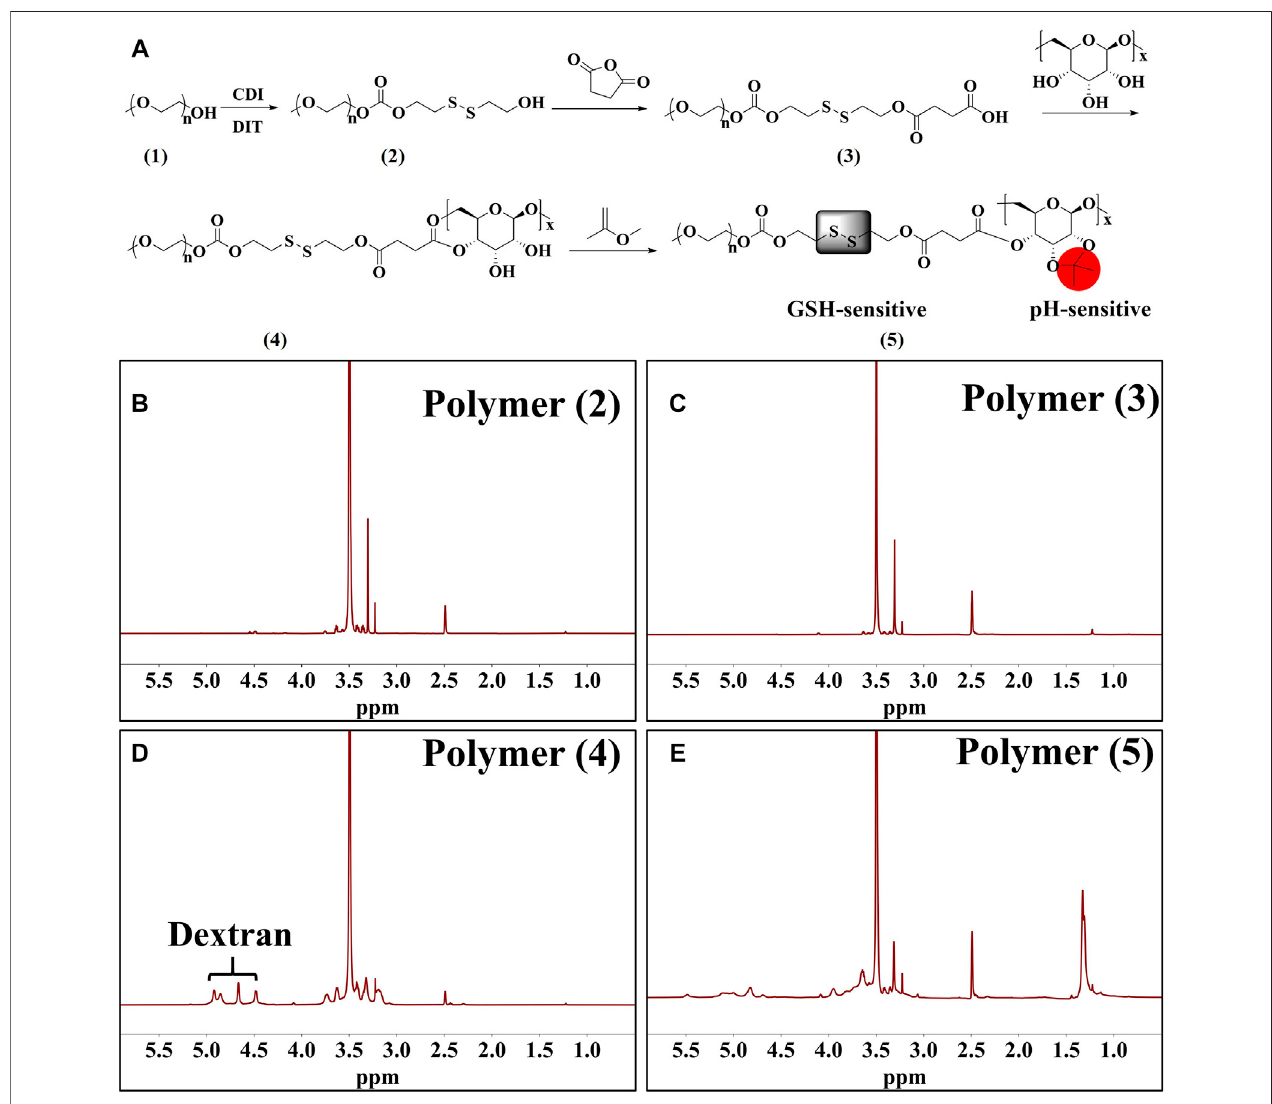
FIGURE 2 | (A) Synthetic route of dual-responsive amphiphilic polymer; 1H NMR spectrum of polymers 2 to 5 (B – E) .